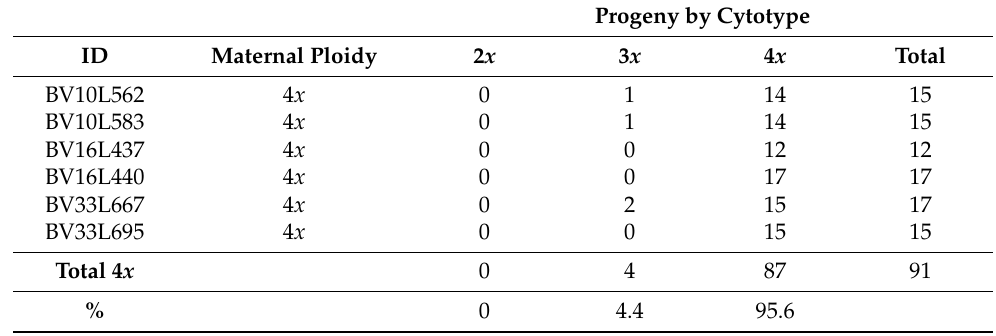
Table 6. Ploidy determination from the field trial of OP progeny from 4 x parents sampled at age 3 years.